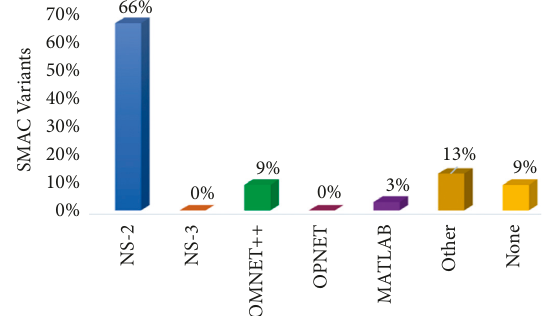
Figure 10: Distribution of WSN simulators used in SMAC